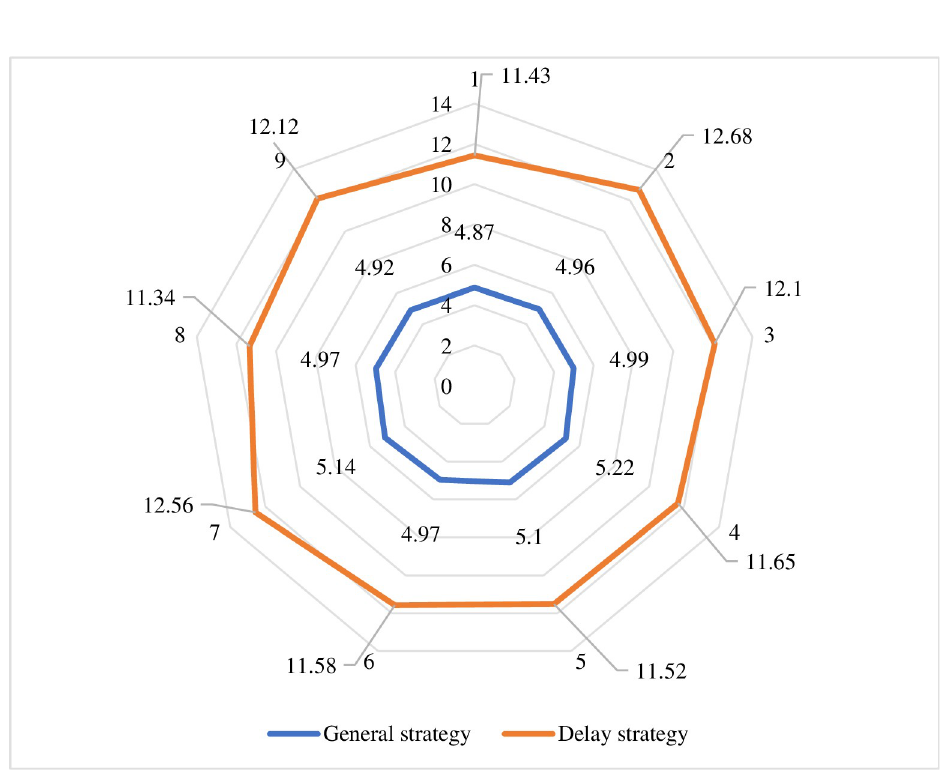
Fig 11. Comparison of simulation results under conventional strategy and delay